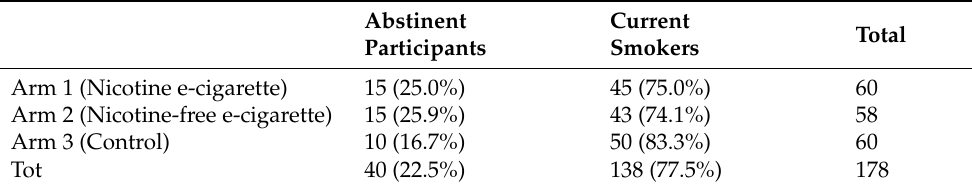
Table 4. Numbers of current smokers and abstinent participants at month 12 by